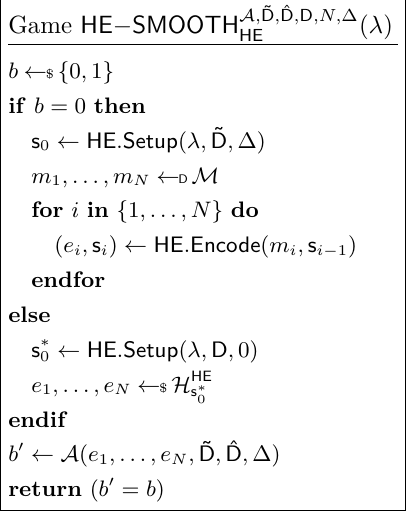
Figure 3: The frequency-smoothing game for an HE